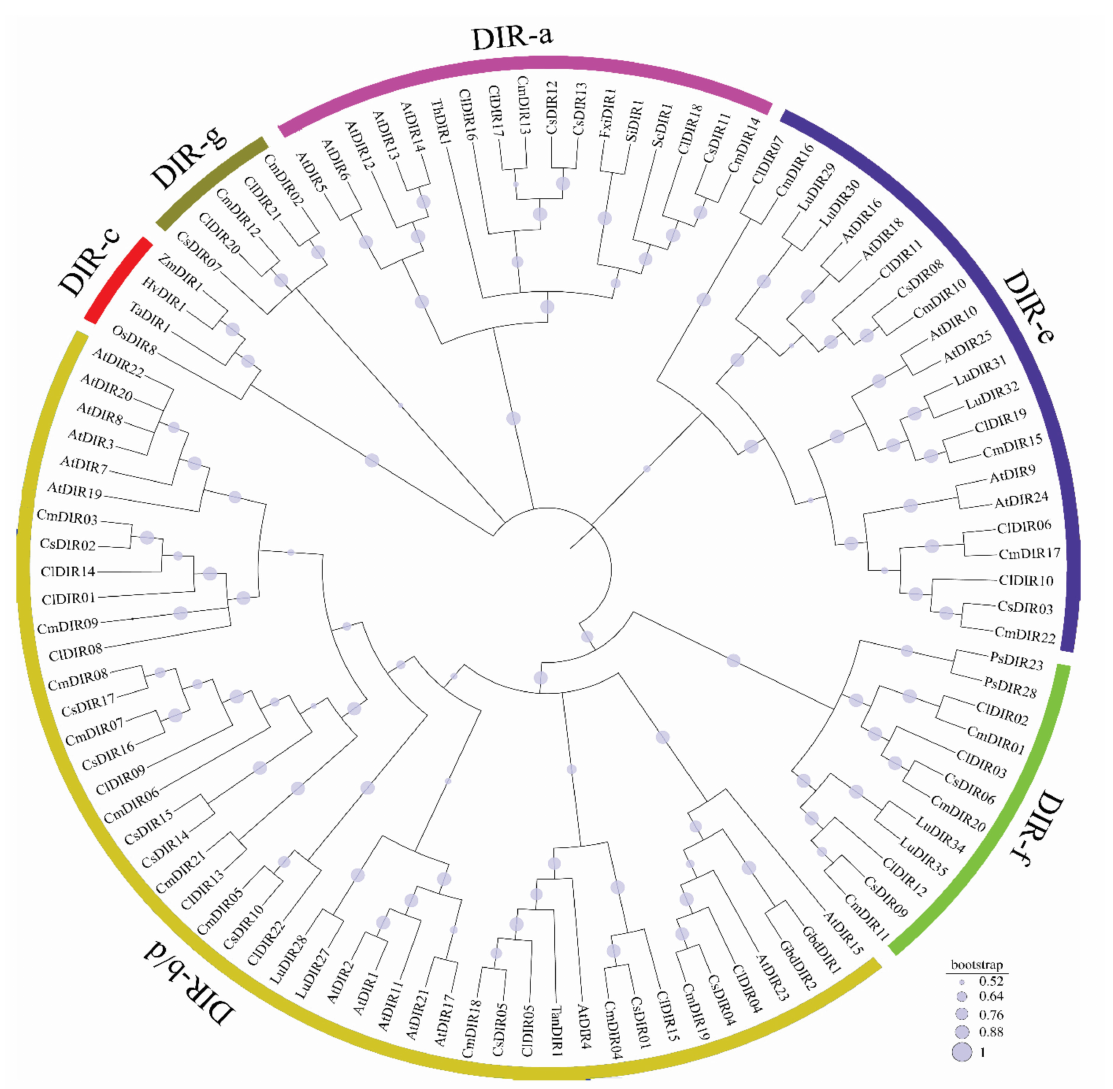
Figure 1. Phylogenetic tree of dirigent proteins identified in different plant species. The evolutionary relationship between different species were inferred using neighbor-joining method by software MEGA-X. The tree was constructed with 1000 bootstrap replications. The evolutionary distances were computed using Poisson correlation method. Six unique groups were identified with high reliability are highlighted in different colors. Plotting was done with online iTOL (https: //itol.embl.de/). Dirigent nomenclature is as follows: At— Arabidopsis thaliana ; Cs— Cucumis sativus ; Cl— Citrullus lanatus